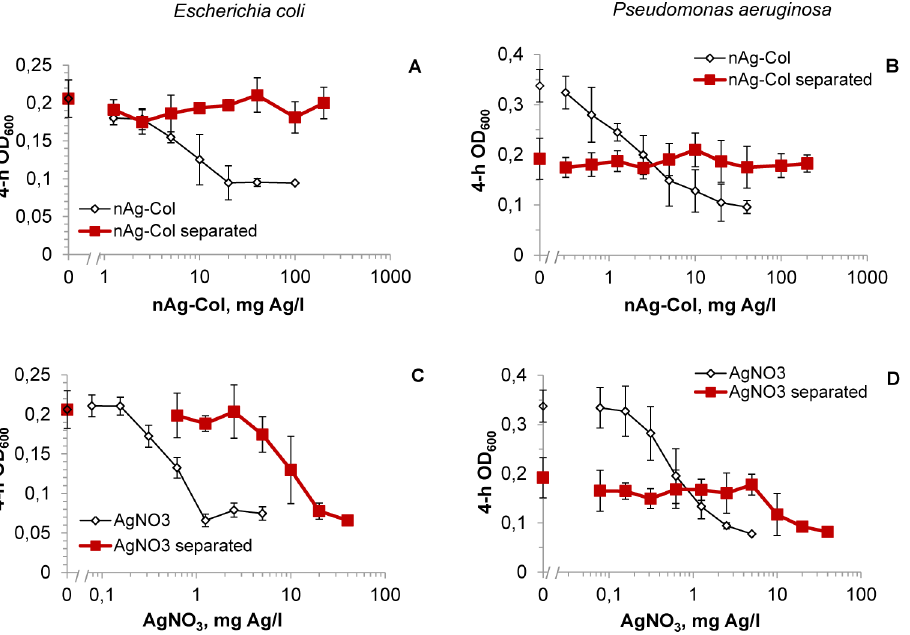
Figure 6. Bacterial growth after 4-h exposure to collargol directly and through the dialysis membrane. Escherichia coli MC1061 (A, C) and Pseudomonas aeruginosa DS10-129 (B, D) upon exposure to collargol (nAg-Col; A, B) after 4 h in half-strength NaCl-free LB at 30 u C in the direct contact with nanoparticles (rectangle) or being separated from particles by 20 kDa (4 nm) cut-off membrane (diamond). AgNO 3 was handled analogously to collargol and was used as a control (C, D). Data represent the average 6 SD